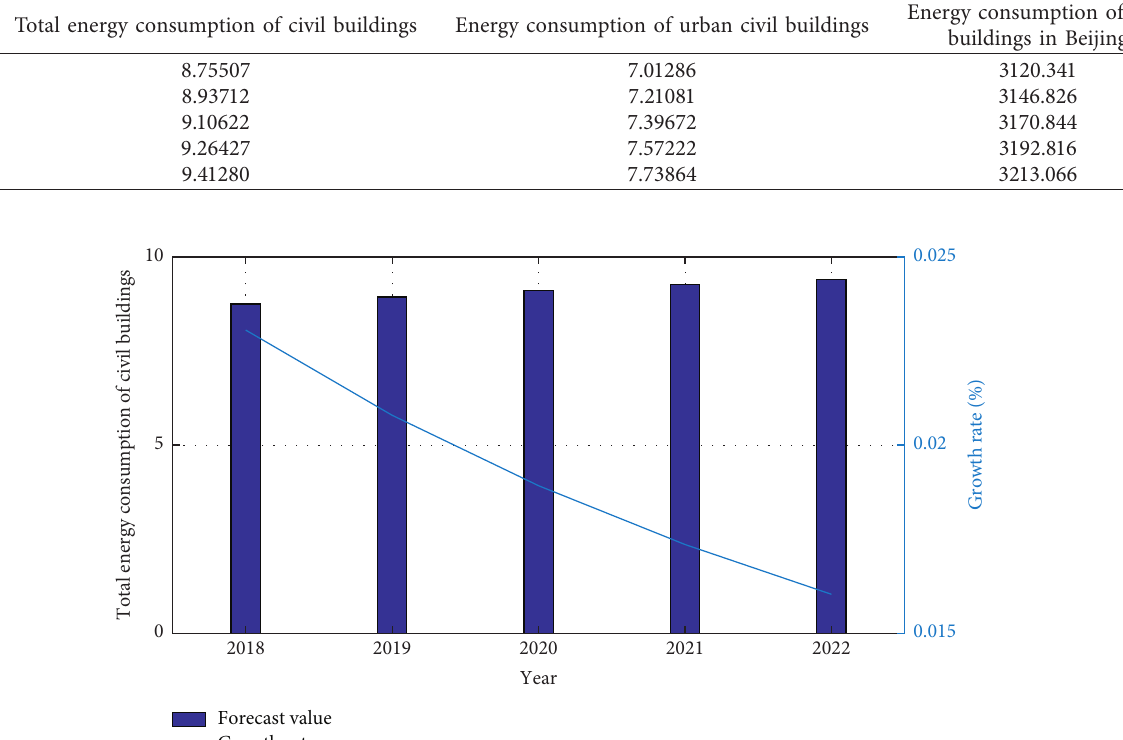
Table 8: Predictions for building energy consumption over the next 5 years.